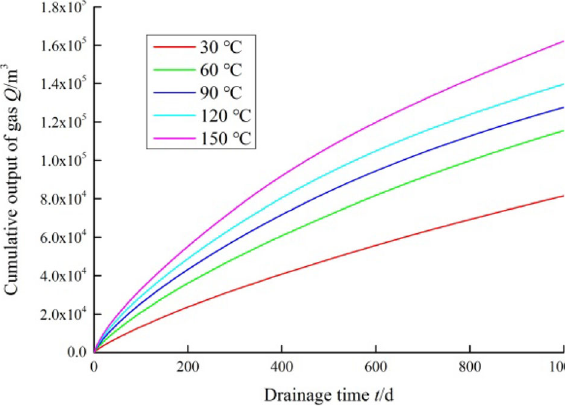
Fig. 9 Cumulative output of gas versus drainage